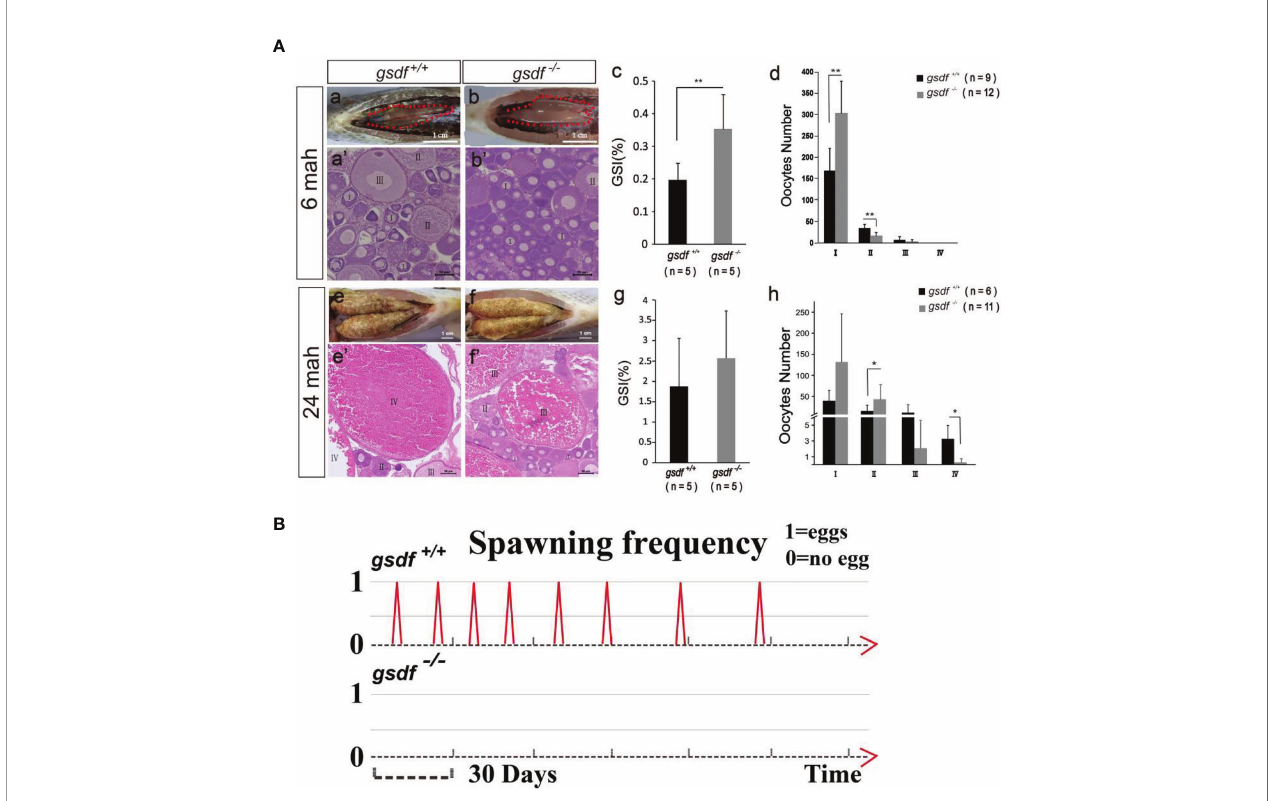
FIGURE 1 | Morphological and histological analyses of ovaries (A) and spawning frequency (B) from XX gsdf +/+ and gsdf - /- tilapia. The fi sh were dissected at 6 and 24 mah. Results are presented as mean ± SD. * and ** indicate signi fi cant differences at P < 0.05 and P < 0.01, respectively. (B) The spawning frequency of 12-months old XX gsdf +/+ and gsdf -/- fi sh were observed for half a year. More than ten XX gsdf -/- fi sh were observed for spawning, while none